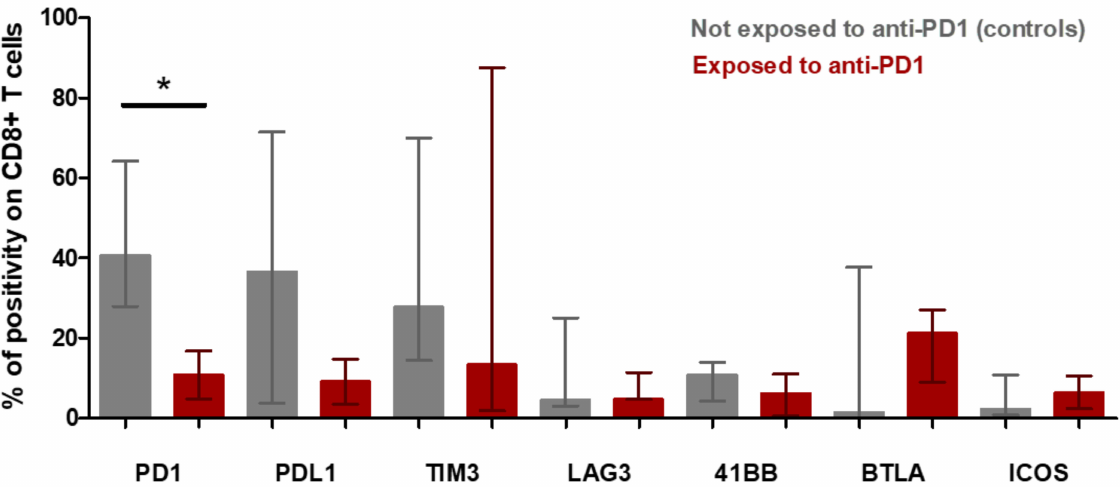
Figure 6. CD8+ t-cell population in microenvironment of Hodgkin lymphoma from patients exposed to anti-PD-1 and not exposed to anti-PD-1 (control patients) (fresh tumor microenvironment cells analysis, part B study). Expression of immune checkpoint markers on CD8+ T cell surfaces of tumor microenvironment. The rectangle indicates the median of values and the bar the interquartile range. The p -value was determined with a Mann–Whitney test with Welch’s correction. * Indicates the median positive expression of PD-1 was found significantly lower in exposed to anti-PD-1 samples compared with controls (10.82 [IQR:5.21–18.30] versus 40.67 [IQR 27.69–64.04]; p = 0.0431). Other markers did not significantly vary between controls and exposed to anti-PD-1